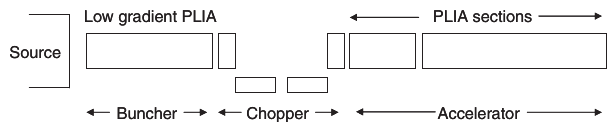
FIG. 3. A schematic of a PLIA-based system with buncher and chopper. The ion buncher consists of a low gradient PLIA, and energy selection and beam chopping is accomplished by a magnetic chicane with four quadrupoles.